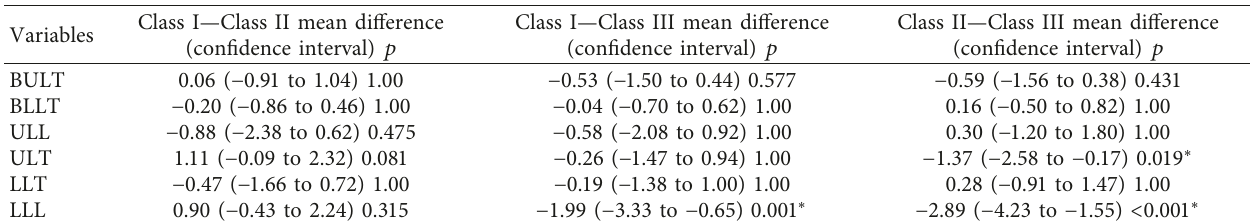
Table 4: Intergroup comparison of lip variables among different sagittal skeletal groups.